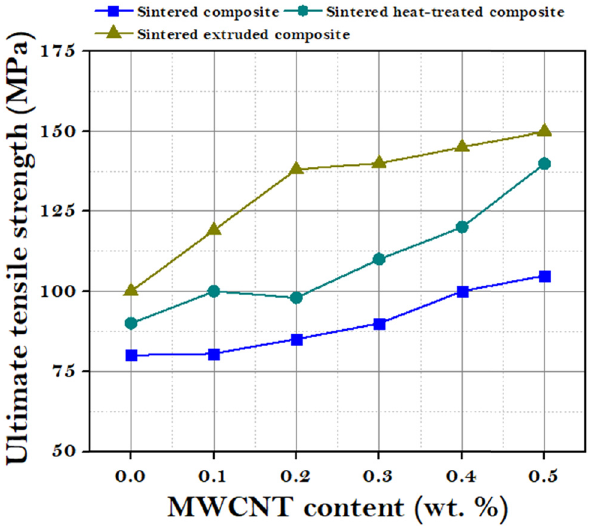
Figure 9: Ultimate tensile strength of sintered, heat - treated, and extruded samples plotted against wt% of